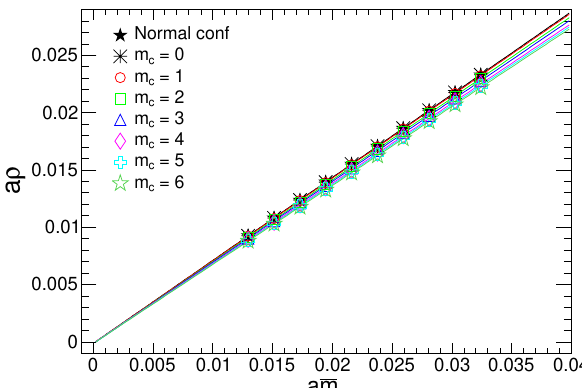
Figure 12 . The ratio a(cid:26) of the correlation functions versus the bare quark mass a (cid:22) m q . The colored lines indicate the (cid:12)tting results.